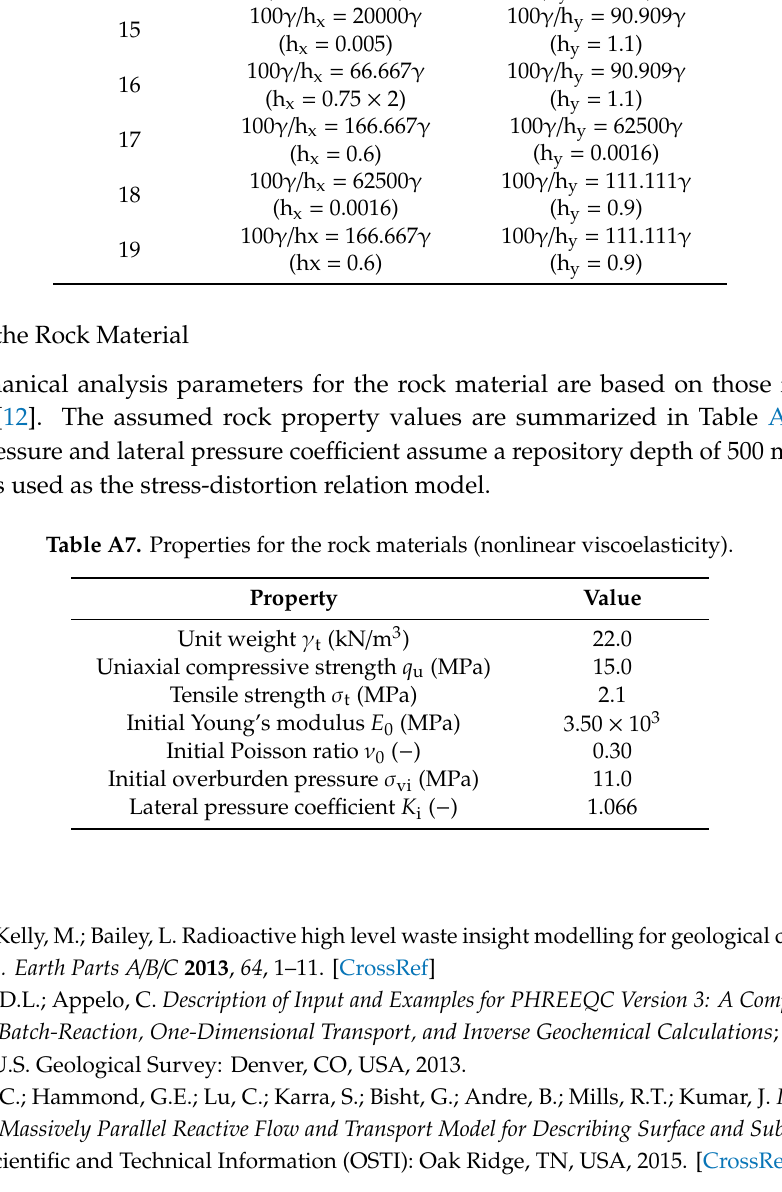
Figure A2. The shape of steel package ( a ) and drum can ( b ) [12].